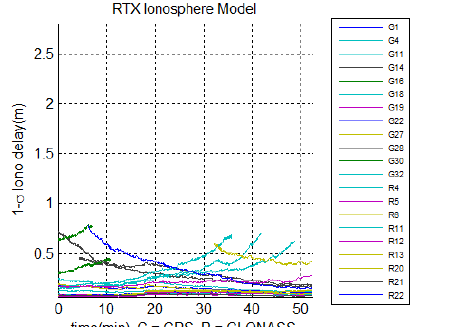
Figure 9: Ionospheric correction accuracy (1-σ ) for the dataset with the fastest position fixing (5.4 min)